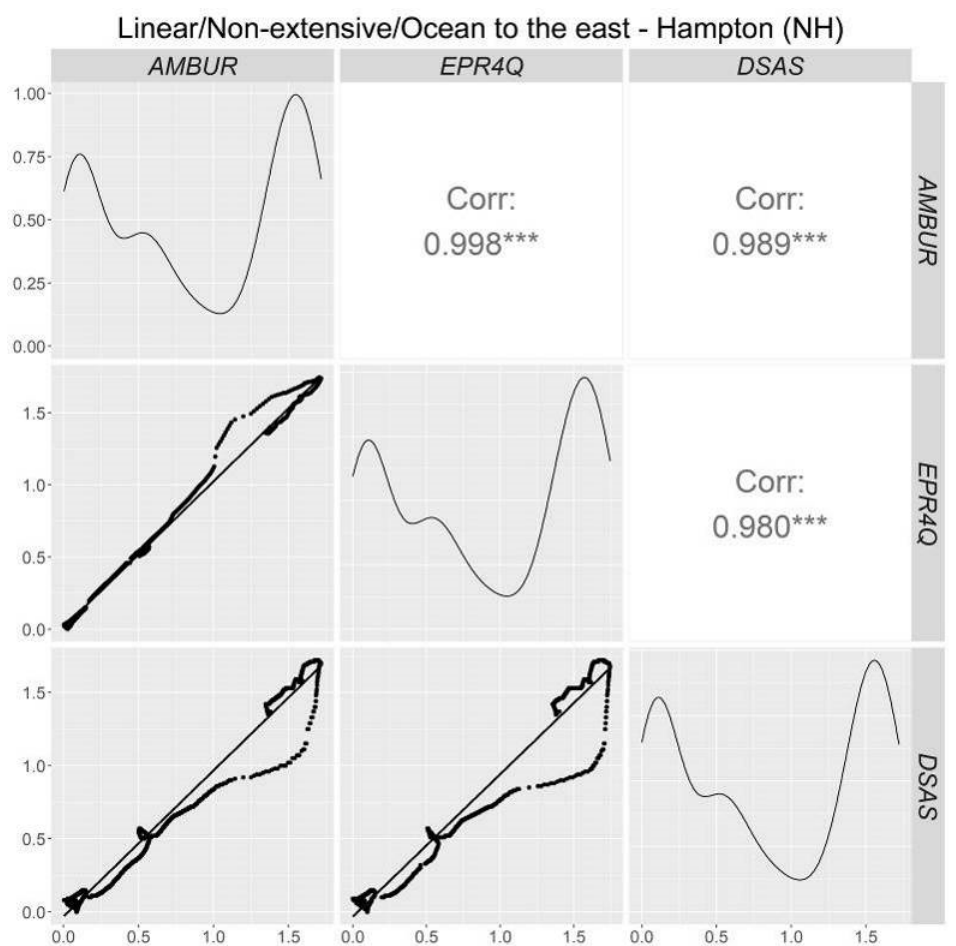
Figure 10. Matrix correlation of AMBUR, EPR4Q, and DSAS models on Linear/Non-extensive/Ocean to the east for Hampton coast. p -value significance symbols: “***”—0.001; “**”—0.01; “*”—0.05; “.”—0.1; No symbol —1. The matrix correlation shows the scatter plot between the models (EPR4Q × DSAS, EPR4Q × AMBUR, AMBUR × DSAS) on the left side. The frequency curve of the histogram of each model on diagonal and Pearson’s correlation is presented on the right. The results show a displacement in the DSAS transects of 23 meters when compared with AMBUR and EPR4Q results. It is also possible to see a difference in the angle (7 ◦ ) of transects on EPR4Q in comparison with the reference transects (AMBUR) (Figure 11—white